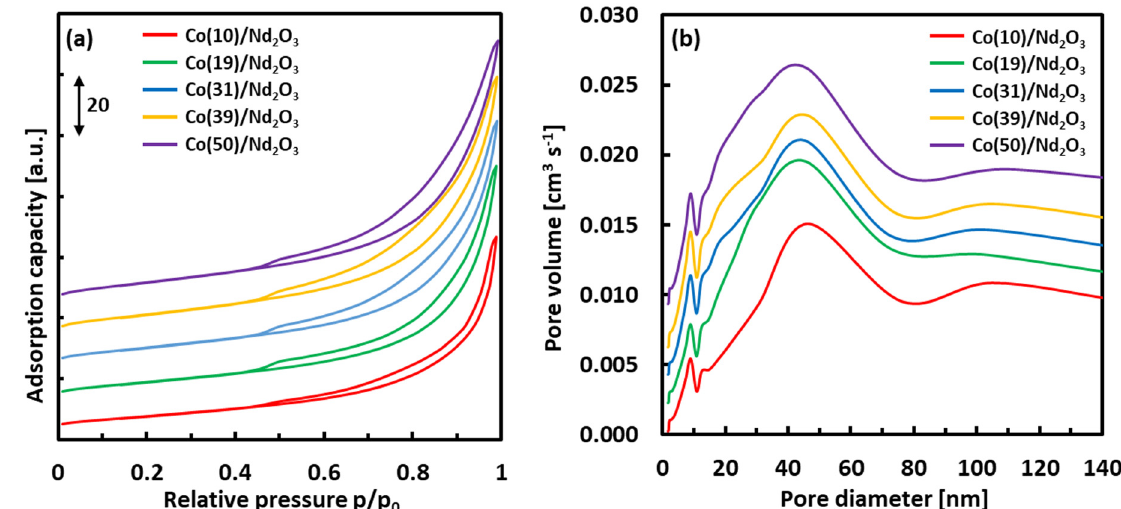
Figure 1. N 2 physisorption isotherms ( a ) and pore volume distribution ( b ) of cobalt catalyst precursors. X-ray powder diffraction studies (XRPD) were carried out to determine the phase composition of catalysts. Figure 2 depicts patterns of cobalt catalyst in the form of a precursor and in-situ reduced form.